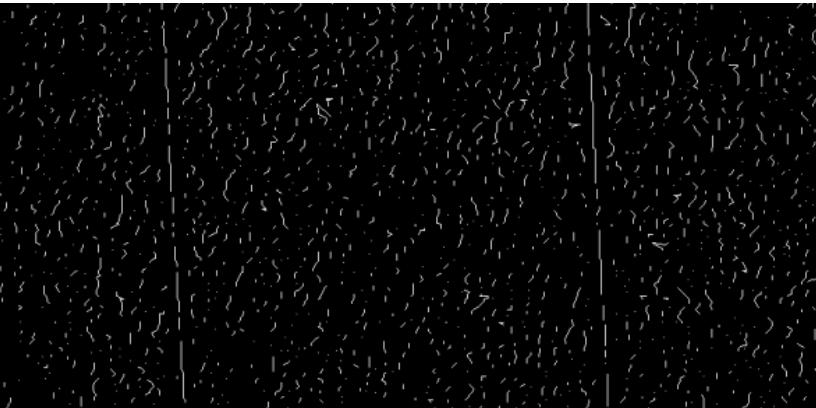
Figure 8. Partially enlarged image of the power line feature extraction result.